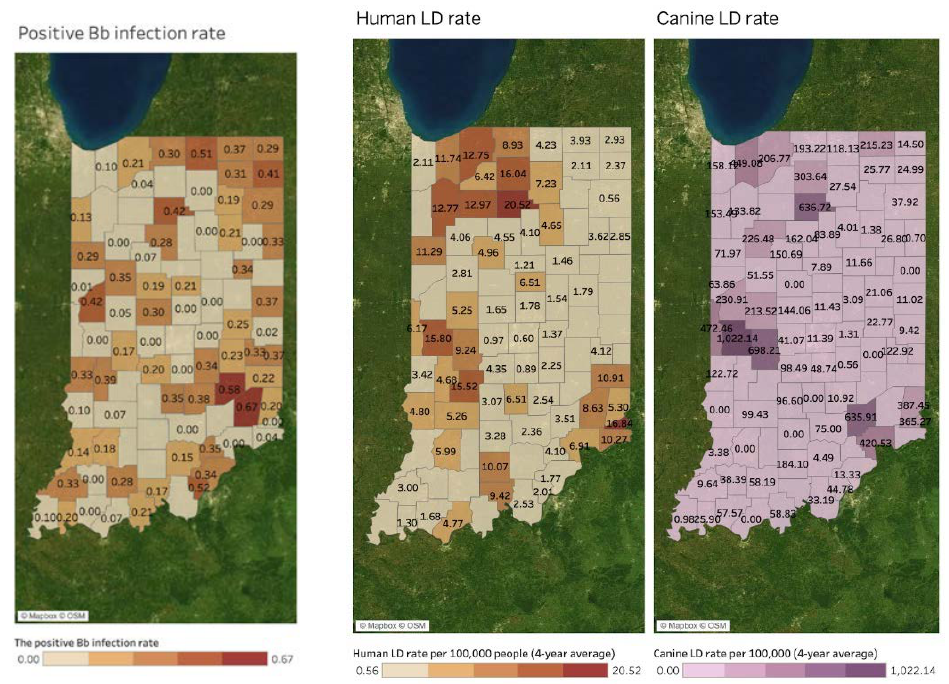
Figure 3. Tick infectivity rate, human LD, and canine LD rates by county (4-year average between 2017 and 2020).